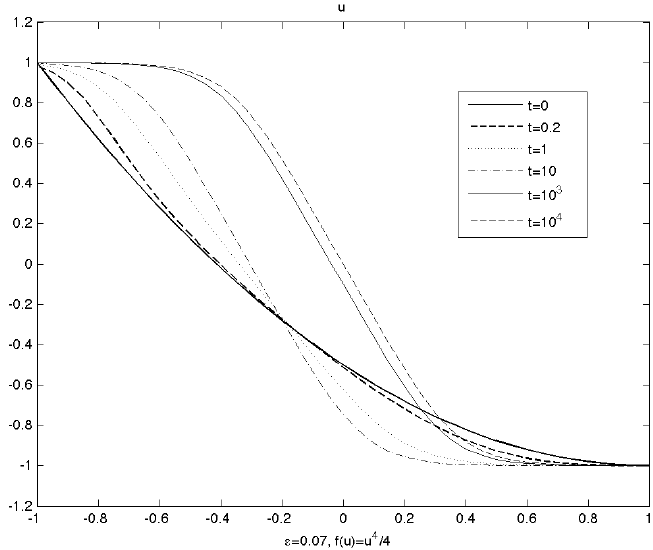
Figure 2. The shock layer profile for f ( u ) = u 4 / 4 and ε =